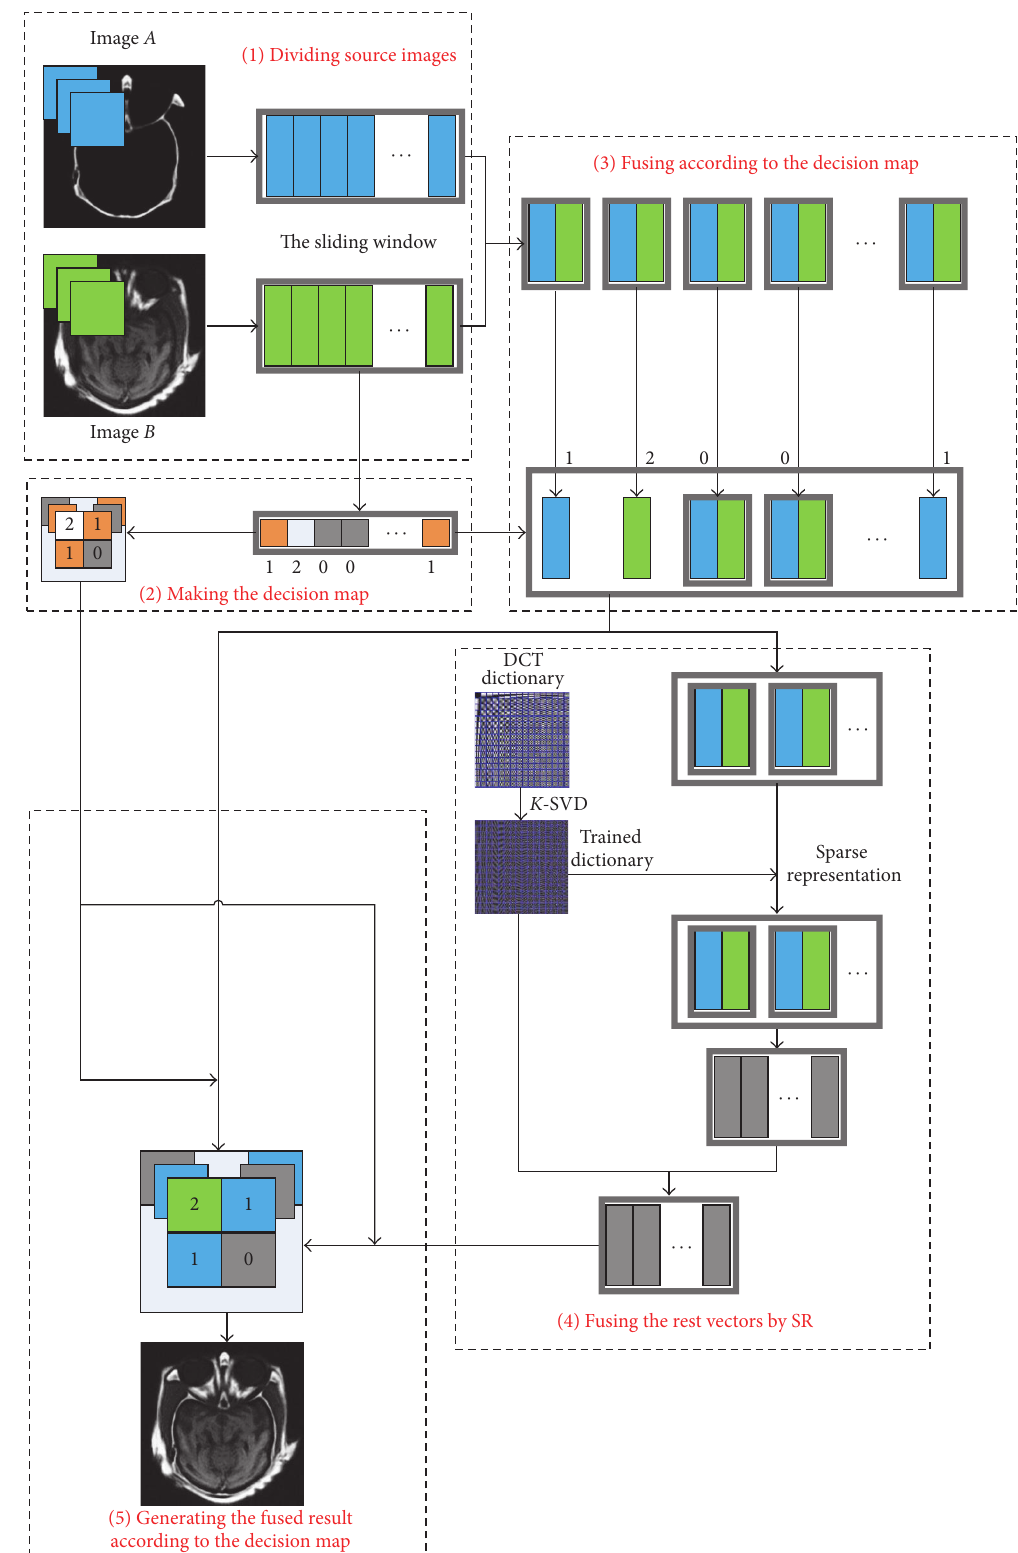
Figure 1: The framework of the image fusion method based on sparse representation and feature